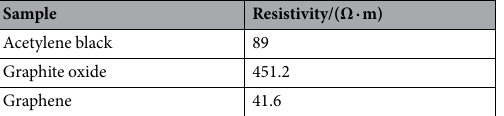
Resistivity of acetylene black, graphite oxide and grapheme.